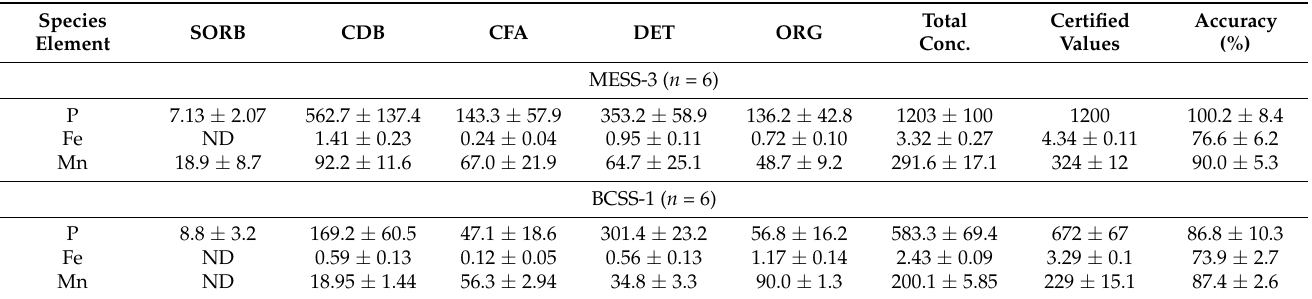
Table 1. The analytical accuracy and precision (1std) of P, Fe and Mn of the MESS-3 and BCSS-1 reference materials are analyzed using the SEDEX method. (Concentration unit, P and Mn in mg/kg; Fe in %). Species